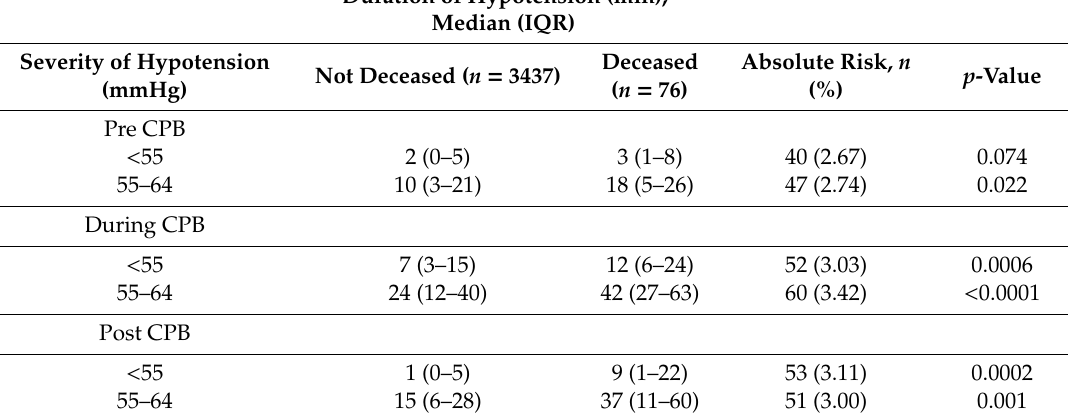
Table 3. Median durations of hypotension before, during and post cardiopulmonary bypass (CPB) and their corresponding morality risk in intermediate-risk patients. Absolute risk was defined as n (%) of patients who died after experiencing longer than median duration of hypotension at each of the Mean Arterial Pressure (MAP)